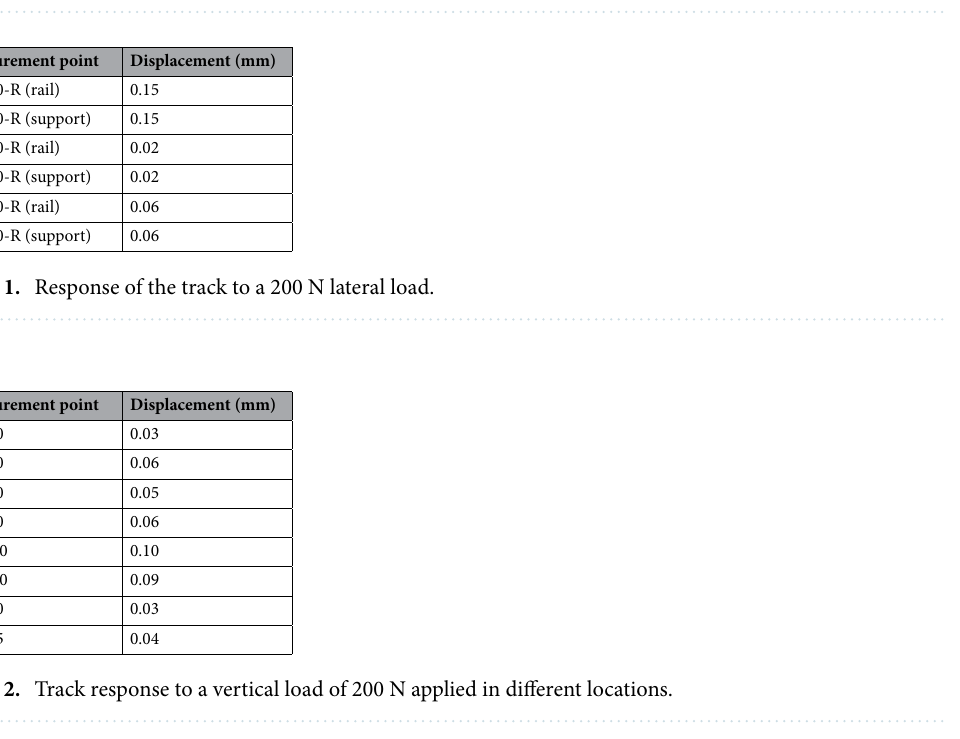
Figure 15. Measurement of track response to concentrated loads. Lateral loading with pulley, mass and dial gauge (left), lateral loading with dynamometer and dial gauge (center), and vertical loading with mass and dial gauge (right).